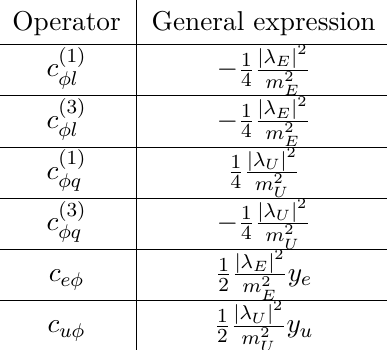
= m = Λ is trivial. E U